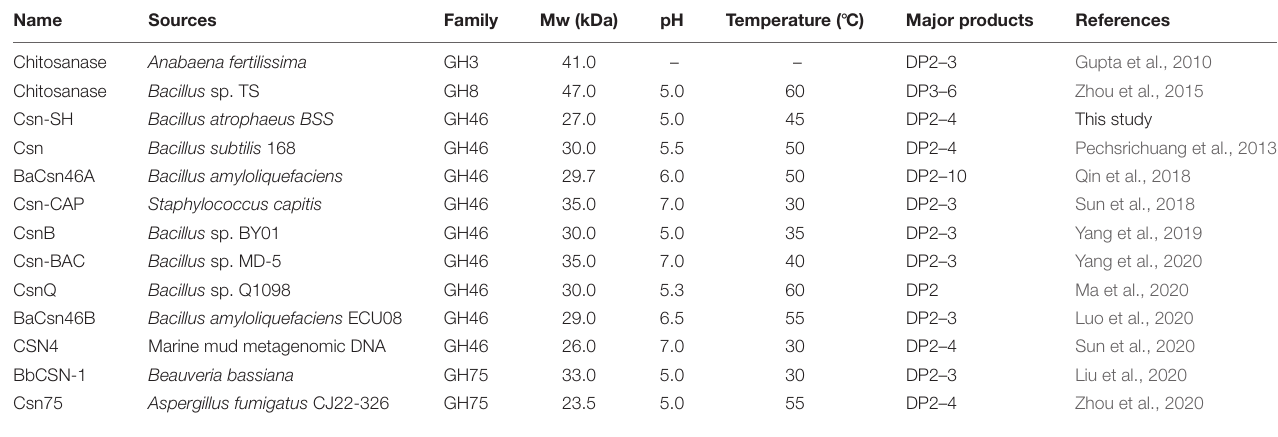
TABLE 1 | The characteristics of chitosanases from different